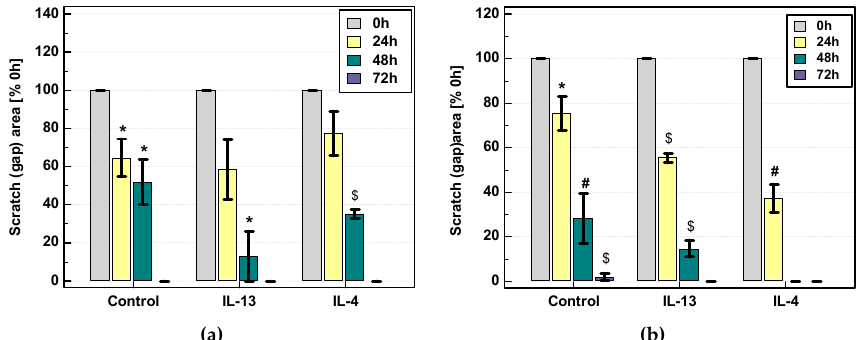
Figure 16. Analysis of the scratch assay data. Effect of IL-4 and IL-13 stimulation (100 ng/mL) on: ( a ) Caco-2 cells; ( b ) HCT 116 cells. Results at each time point are expressed as a percentage of gap area considering the gap at the time 0 as 100%. Each bar represents mean ± SE of three (Caco-2) or four (HCT116) biological replicates. Statistically significant differences as compared to time 0, analyzed using t -test for one mean, are marked as follows: p < 0.05 as *; p < 0.01 as #; p < 0.001 as $.